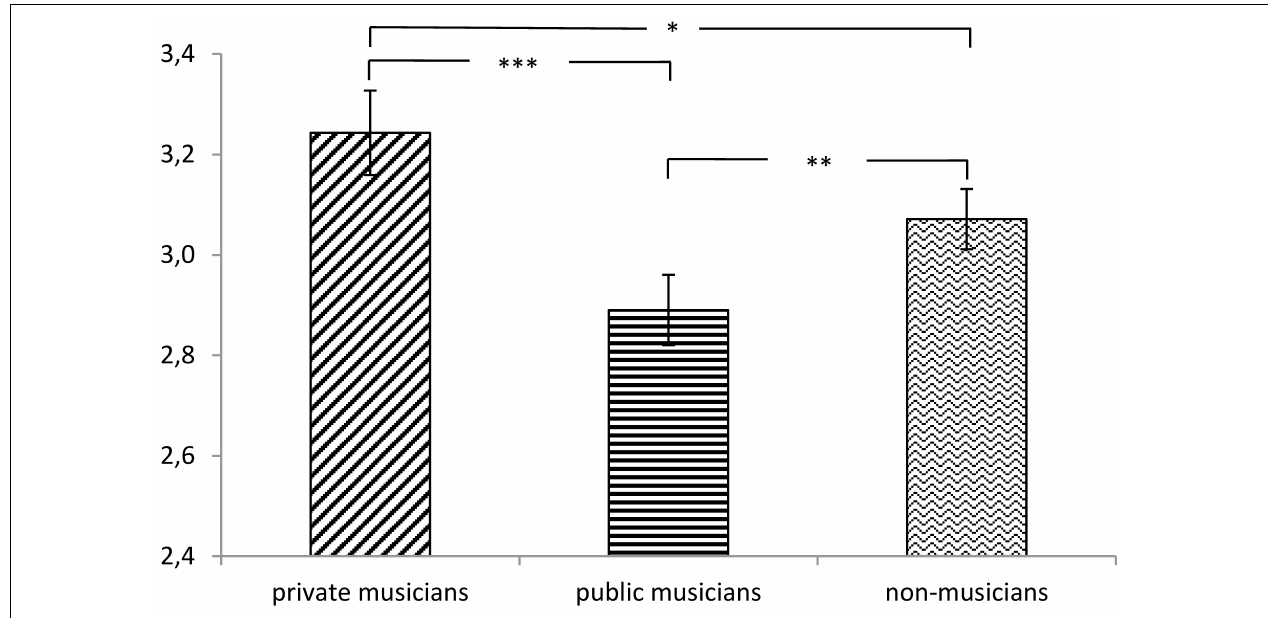
FIGURE 3 | Means and standard errors for attractiveness ratings of profiles for private, public, and non-musicians. ∗ p < 0.05, ∗∗ p < 0.01, ∗∗∗ p < 0.001.